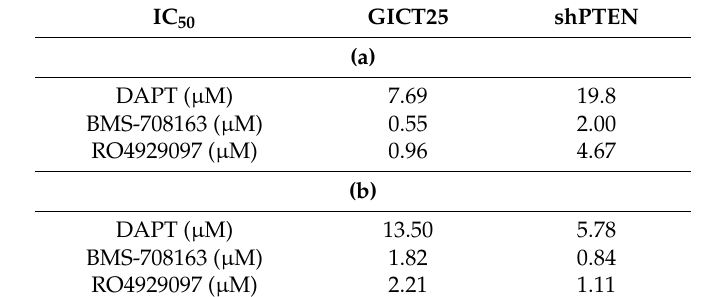
Table 1. PTEN expression is required for the GSI response in cell growth inhibition. ( a ) PTEN knockdown decreased the response to GSI in PTEN–wild-type GIC. ( b ) PTEN expression increased the response to GSI in PTEN-mutant GIC.